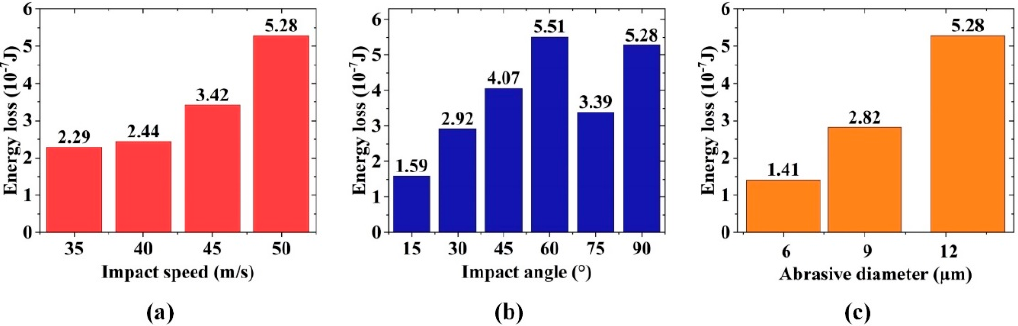
Figure 13. Energy loss changes under different impact parameters: ( a ) impact speed, ( b ) impact angle, and ( c ) particle diameter.